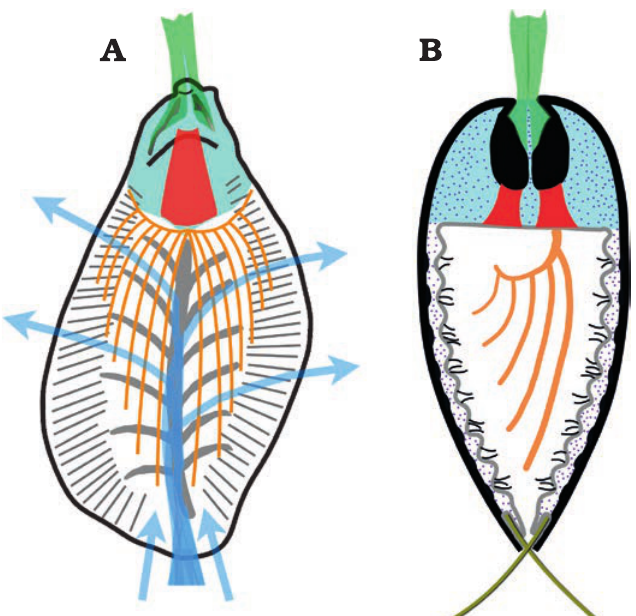
Fig. 13. Stylized anatomical reconstruction of the stenothecoid pan-brachio- pod Stenothecoides rasettii sp. nov. A . Dorsal valve, plan view. B . Lon gi- tudinal section slightly off the midline of the valves and normal to commis- sure. Colors: black in A, shell outline; black in B, valves and juxtaposed apical bosses; green, pedicle, inserting on posterior surface of apical boss and in cardinal troughs; red, muscles originating on anterior surface of api- cal boss and attaching to the anterior body wall; turquoise, visceral mass; orange, lophophore; grey, peripheral and axial furrow zones; short black lines, cilia in grooves between mantle canals; blue arrows, inferred inhalant and exhalant water currents; dotted areas, coelomic fluid; olive green, setae (omitted in A). Lophophore modelled after Heliomedusa (Chen et al.